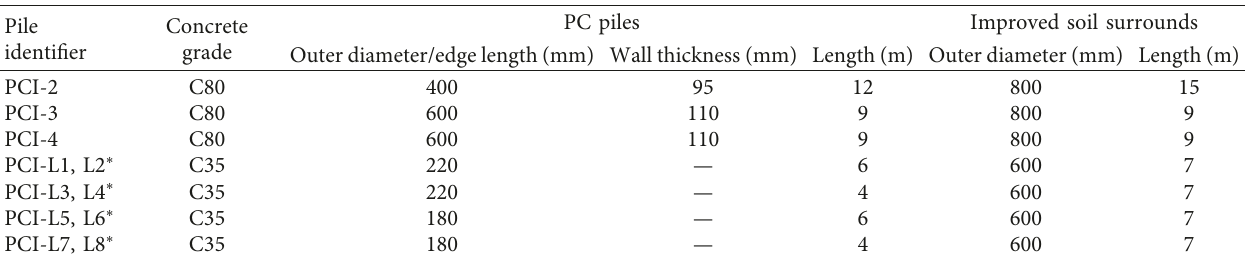
Figure 7: Deduced m - Y 0 curves for lateral test Table 4: Detailed information of test piles (PCI-2 ∼ PCI-4; PCI-L1 ∼ PCI-L8).